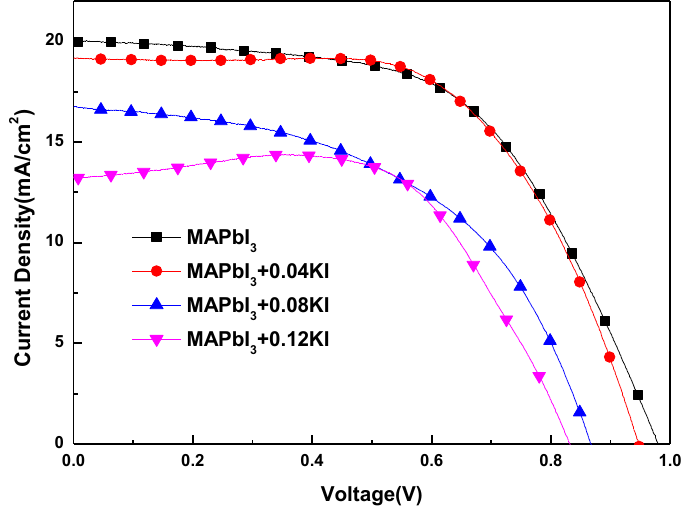
Figure 7. J–V curves of perovskite devices with di ff erent K + Figure 7. J – V curves of perovskite devices with different K + concentrations. Table 3. Photovoltaic parameters of perovskite devices with different K + concentrations.